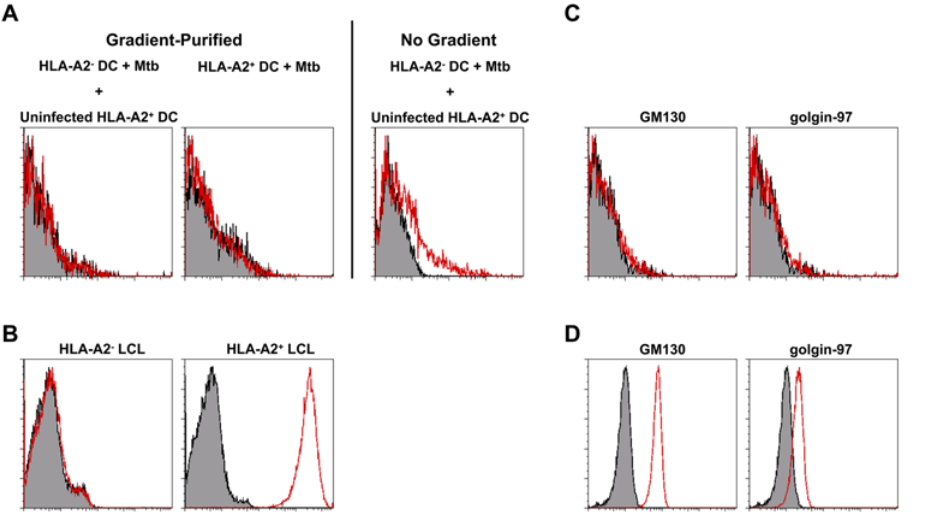
Figure 5. Mtb phagosomes contain minimal contamination. (A) HLA-A2 2 or HLA-A2 + DC were infected with H37Rv-eGFP for 20 minutes, washed, and incubated for an additional 40 minutes. HLA-A2 2 DC were mixed with uninfected HLA-A2 + DC, homogenized, and homogenate separated using 27% percoll as described or pelleted without percoll separation. Phagosomes were stained with an antibody to HLA-A2. Shaded histograms represent isotype staining. Data are representative of three experiments. (B) HLA-A2 2 or HLA-A2 + LCL were fixed, permeabilized, and stained with an antibody to HLA-A2. (C,D) Mtb phagosomes (C) or intact DC (D) were analyzed for the presence of cis- and trans-golgi markers GM130 and golgin-97, respectively. Data in C are representative of three experiments each after a 40 minute or overnight chase. Data in D are representative of two experiments. (Figure 5D). Together, these data suggest that HLA-I and associated loading accessory molecules are bona fide constituents of the Mtb phagosome.